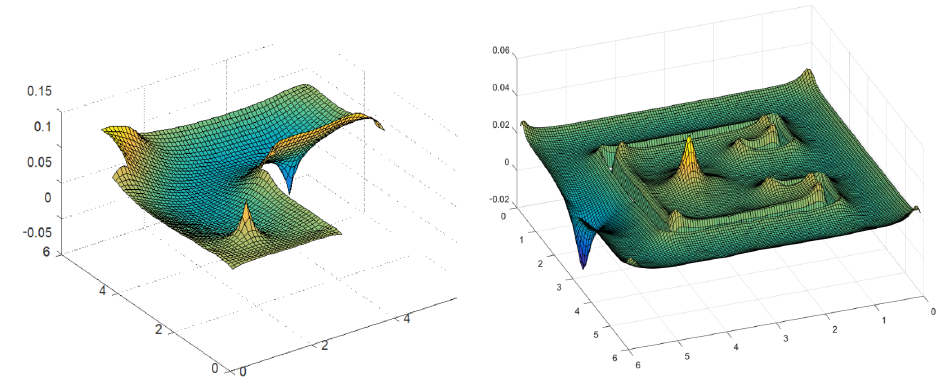
Figure 2. PGD reconstruction (potential field mesh) for two arbitrary start and goal locations in a ( left ) L-shaped corridor and ( right ) a bug trap planning environment.